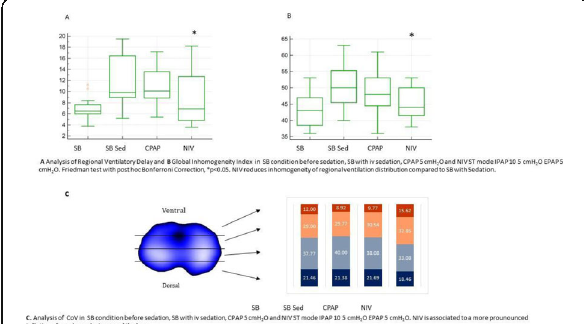
Fig. 1 (abstract A139). See text for